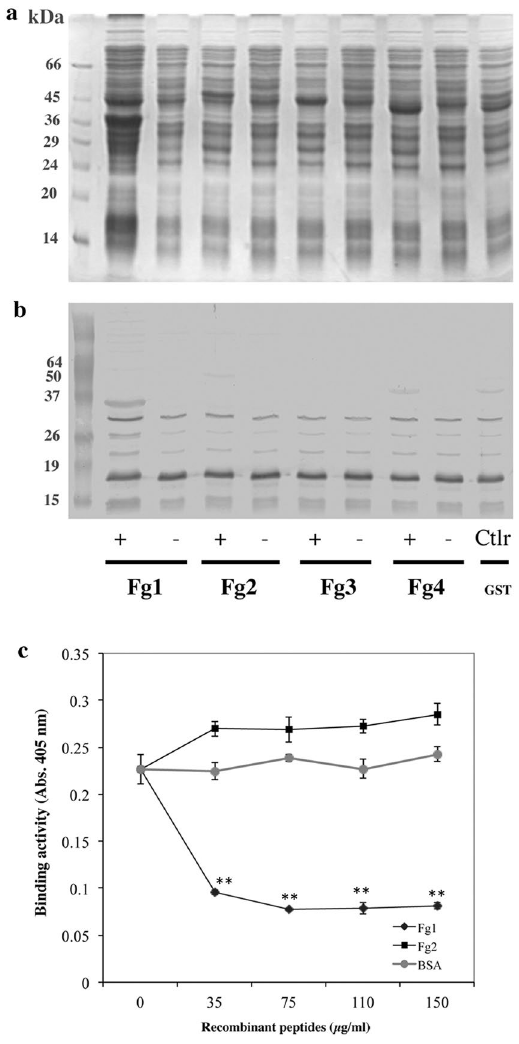
Figure 5. Inhibition of DsA1 binding to fibrinogen by a peptide derived from the N-terminus of fibrinogen. ( a ) GST-recombinant proteins (Fg1, Fg2, Fg3, Fg4) were expressed in E. coli (see Supplementary Figs S1 and S2) , fractionated by 12.5% SDS-PAGE and detected by Coomassie blue staining. ( b ) Proteins were probed with biotinylated DsA1 (0.1 μ g/ml). ( c ) Binding activity to hFg (25 μ g) with pretreated biotinylated DsA1 with purified recombinant peptides Fg1 ( ♦ ), Fg2 ( ■ ) or BSA as control ( ● ). Data are presented as the mean ± standard deviation of four independent experiments. Statistical significance is indicated by * P ≤ 0.05, ** P ≤